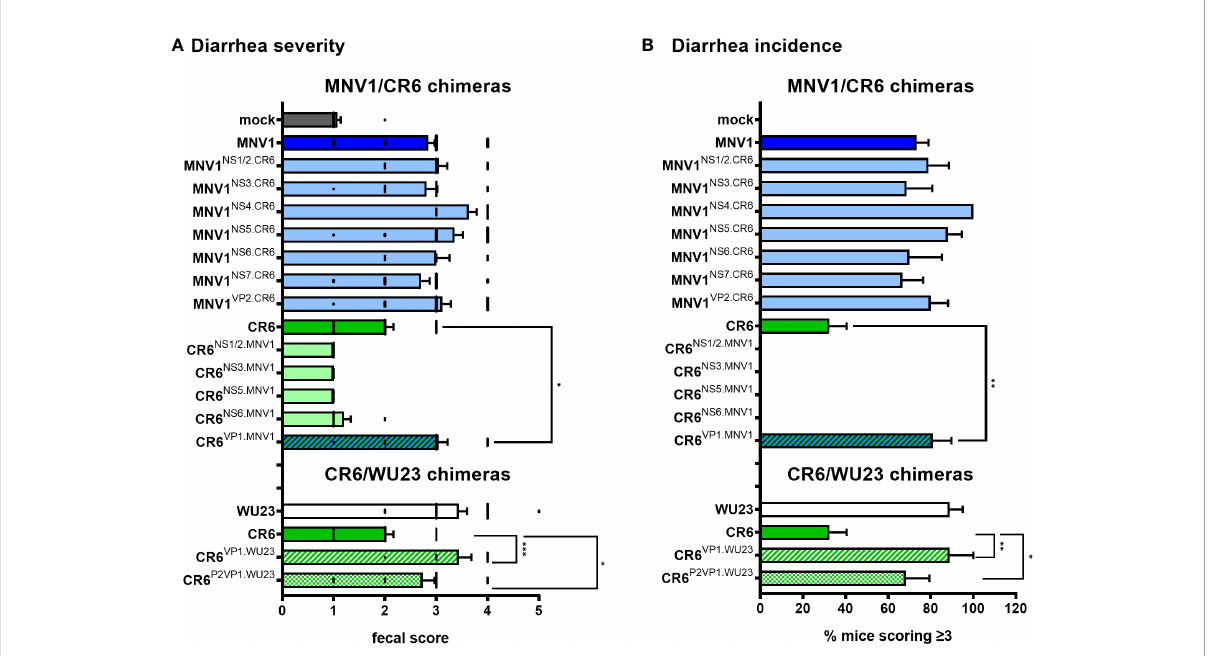
FIGURE 2 The surface-exposed domain of the major capsid protein VP1 is the major MNV virulence factor in BALB/c mice. (A, B) Groups of P3 BALB/c neonatal mice were inoculated with 10 7 TCID 50 units of mock inoculum, WU23, MNV1, CR6, or the indicated chimeric virus. (A) At 2 dpi, fecal consistency was determined by palpating their abdomens. (B) The proportion of mice scoring a 3 or above is presented as incidence of diarrhea. At least 5 mice from at least 2 independent litters per condition were analyzed. P values were determined for the MNV1/CR6 chimeras and the CR6/WU23 chimeras using Kruskal-Wallis test with Dunn ’ s multiple comparisons test by comparing each chimeric virus to its respective parental virus. *P < 0.05, **P < 0.01, ***P <